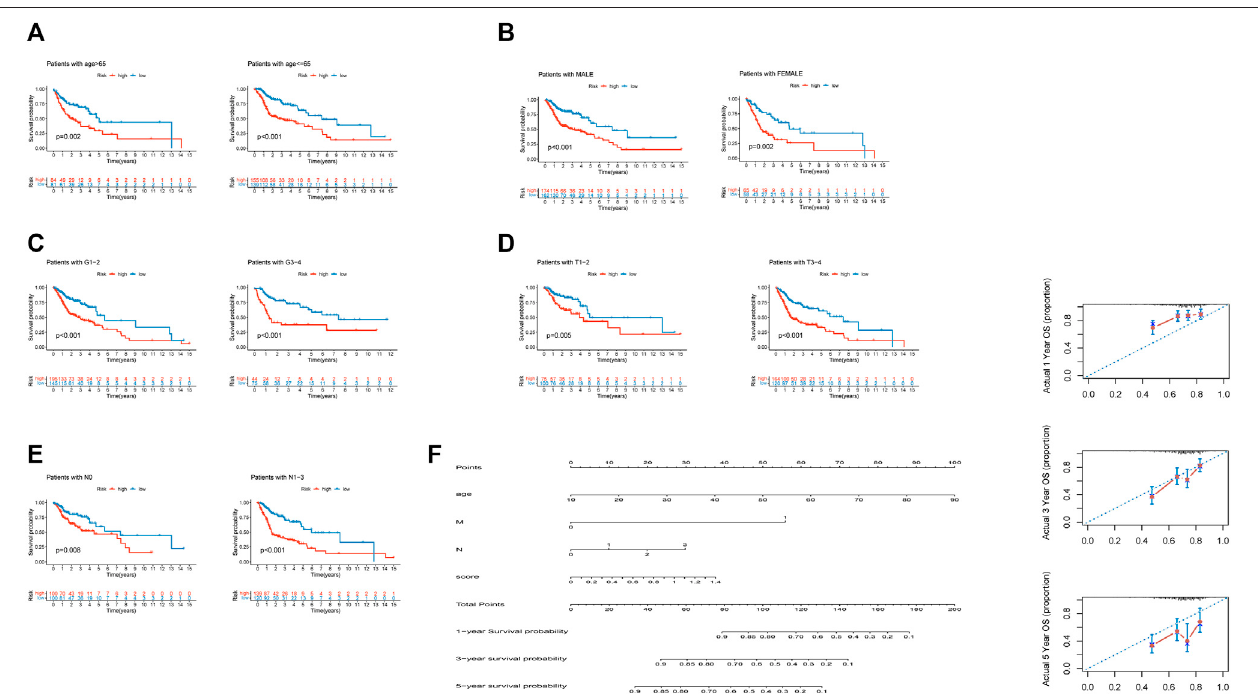
FIGURE 9 | Independence of the model in multiple clinical features and the nomogram prediction of patient survival rate. (A) . Independence between differential ages. (B) . Independence between differential sexes. (C) . Independence between differential grade stages. (D) . Independence between differential T stages. (E) . Independence between differential N stages. (F) . Nomogram predictions of 1-, 3-, and 5 years survival in HNSCC